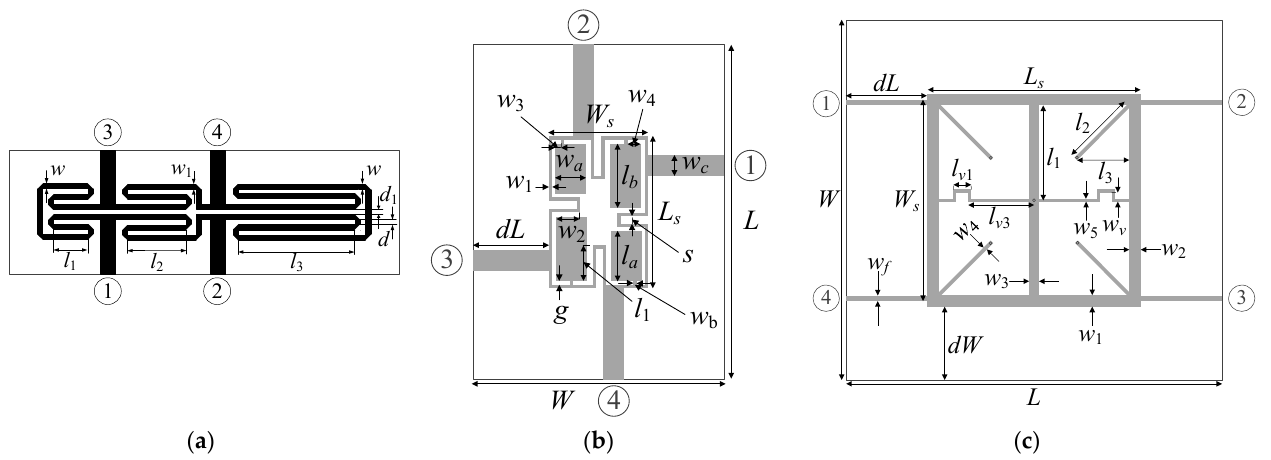
Figure 3. Microwave structures employed for validation of the proposed design centering algorithm: ( a ) compact rat-race coupler (Circuit I) [40], ( b ) miniaturized branch-line coupler (Circuit II) [41], ( c ) dual-band branch-line coupler (Circuit III) [42]. Table 1. Validation circuits.